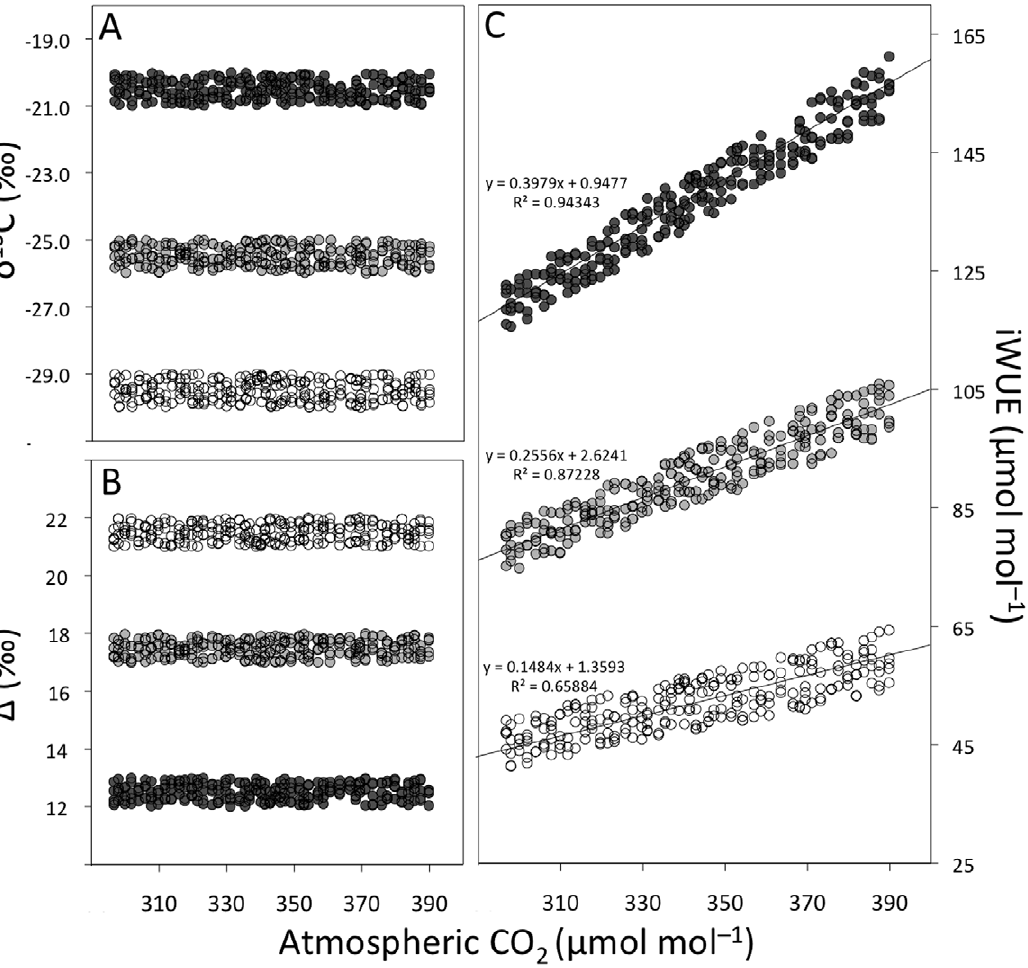
Figure 1. Simulated d 13 C data, randomized within three different ranges: 2 20 to 2 21 % (dark grey circles); 2 25 to 2 26 % (light grey circles) and 2 29 to 2 30 % (white circles). (A). Source to product 13 C discrimination calculated from simulated d 13 C according to eq. 2 using atmospheric d 13 C value of 2 8 % (B). Estimated iWUE calculated from simulated d 13 C and D following eq. 3 (C). Note that significant (P , 0.001) positive relationships between iWUE and atmospheric CO 2 occur despite no changes in d 13 C and D .